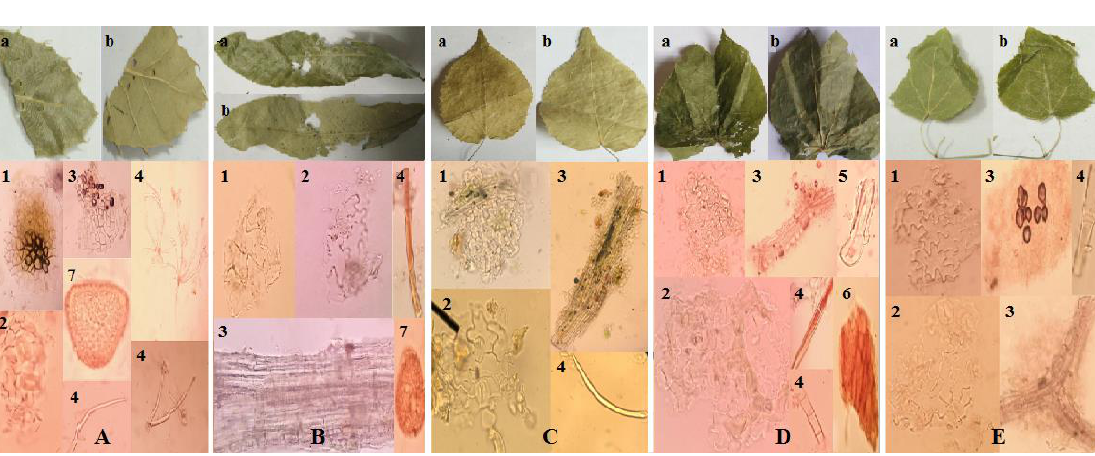
Figure 1. The appearance and microscopic features of Epimedium samples: ( A ) E. sagittatum (Sieb.et Zucc.) Maxim.; ( B ) E. koreanum Nakai; ( C ) E. wushanense T. S. Ying; ( D ) E. brevicornu Maxim.; ( E ) E. pubescens Maxim.; (a) leaf upper surface; (b) leaf lower surface; (1) leaf upper epidermis; (2) leaf lower epidermis; (3) fibers; (4) non-glandular hairs; (5) glandular hairs; (6) reddish-brown content; (7) oil cells.